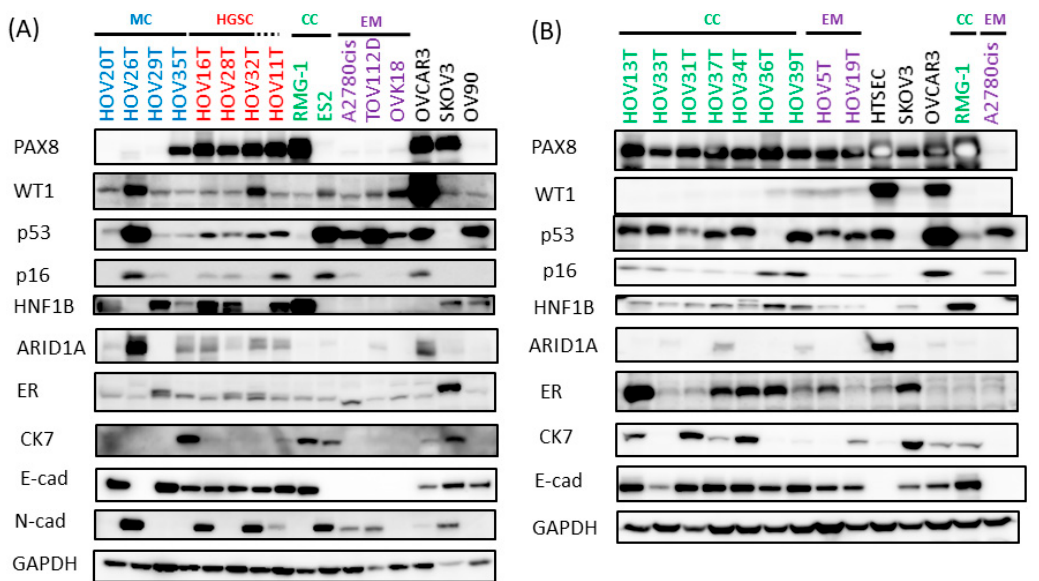
Figure 1. Expression of ovarian cancer several histotype-specific markers in established HOV cell lines and commercially available ovarian cancer cell lines. ( A ) HOV cell lines from mucinous (MC) carcinoma and high-grade serous adenocarcinoma (HGSC) ( B ) HOV cell lines from clear cell (CC) and endometrioid (EM) carcinomas Expression of PAX8, p16, CK7, E-cadherin, HNF1B, ARID1A, WT1, p53 and ER as well as GAPDH as a loading control were detected by Western blotting. Expression of N-cadherin was also detected to examine the sarcomatous feature of HOV26T in (A). RMG-I and ES2 are CC carcinoma cell lines; A2780cis, TOV112D and OVK18 are EM carcinoma cell lines; OV90 is a papillary serous carcinoma cell line; SKOV3 and OVCAR3 are unclassified adenocarcinoma cell lines.